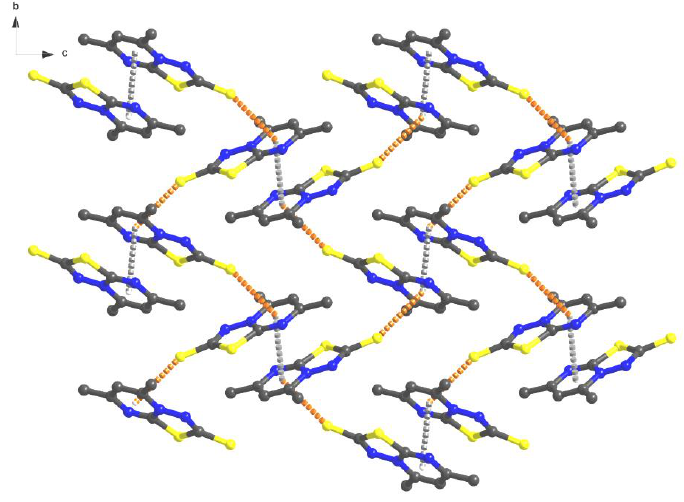
Figure 2. Packing diagram of ( 1 ) with π – π and C = S– π interactions. Table 1. Crystallographic data, details of data collection and structure refinement parameters for ( 1 ) and ( 2